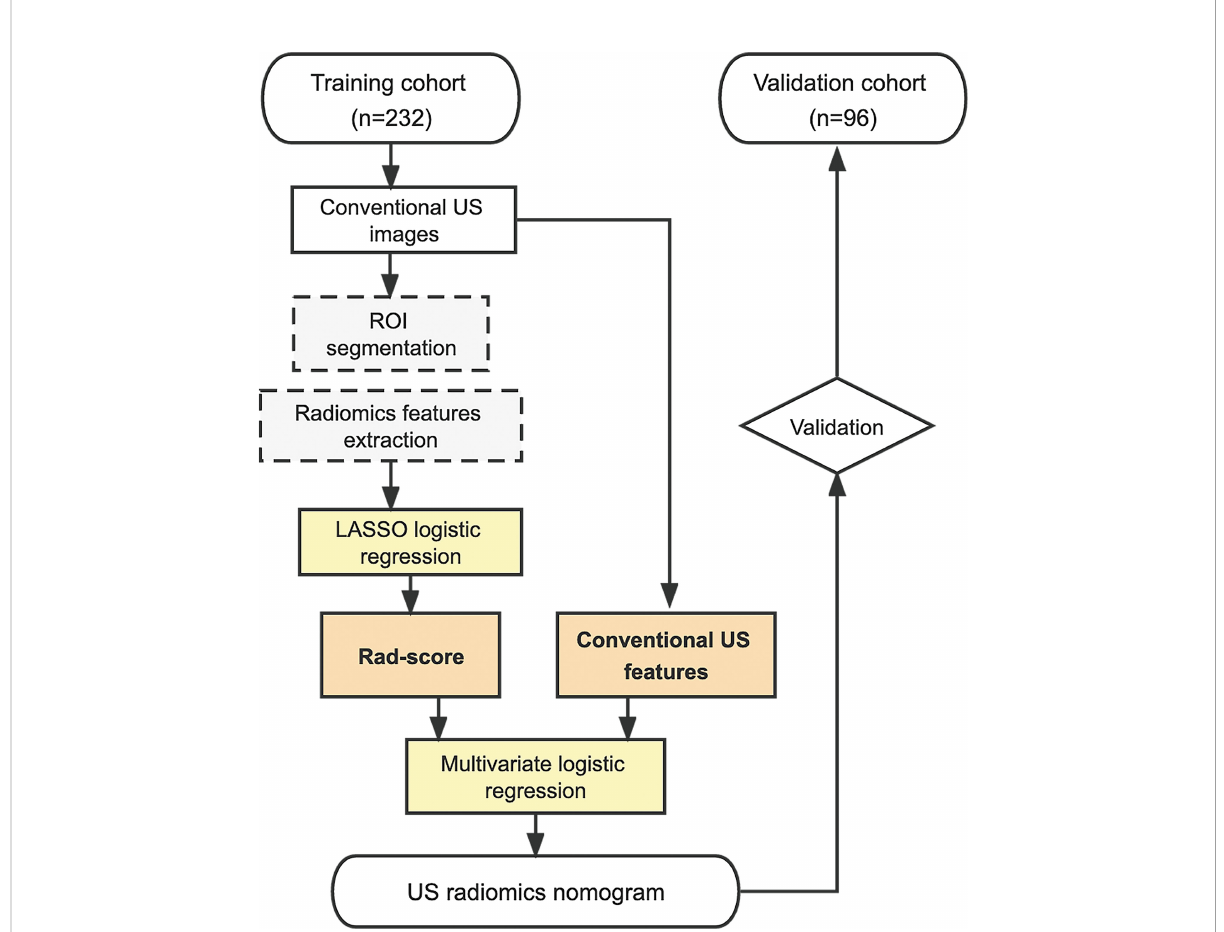
FIGURE 1 Procedure of patient selection and radiomics nomogram development. US, ultrasound; ROI, region of interest; LASSO, least absolute shrinkage and selection operator; Rad-score, radiomics